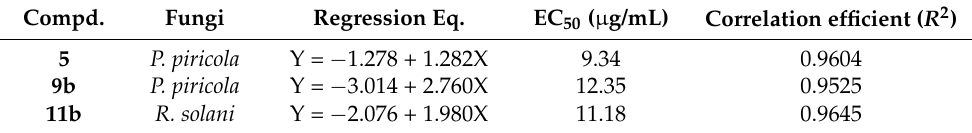
Table 2. The EC 50 values for compounds 5 , 9b and 11b against different phytopathogens. Compd.